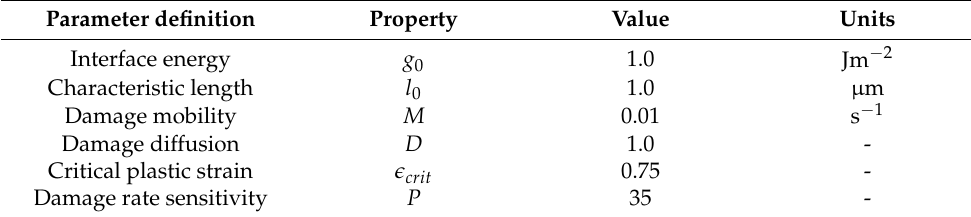
Table 3. Physical and fitting damage parameter values used for austenitic phase. Parameter